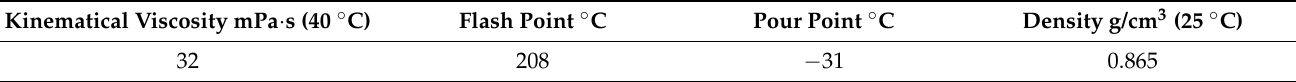
Table 1. Basic physical parameters of L-AN32 base carrier.